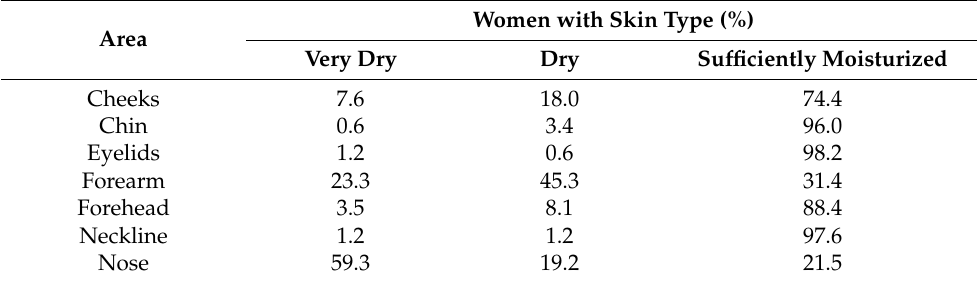
Table 5. Percentage of young women with each degree of lubrication of the examined skin areas. Women with Skin Type Area